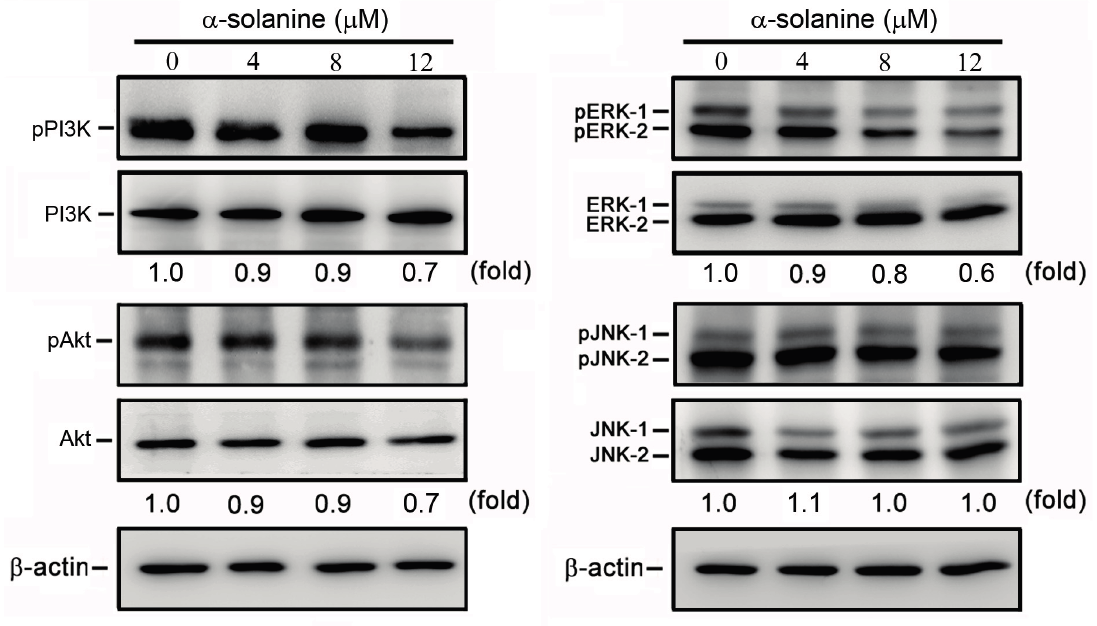
Figure 6. Effects of α -solanine on phosphorylation of PI3K, Akt, ERK1/2 and JNK1/2. Cells were treated with solanine for 24 h and the phosphorylation of PI3K, Akt, ERK1/2 and JNK1/2 were determined by SDS-PAGE and western blotting. β -actin was used as a loading